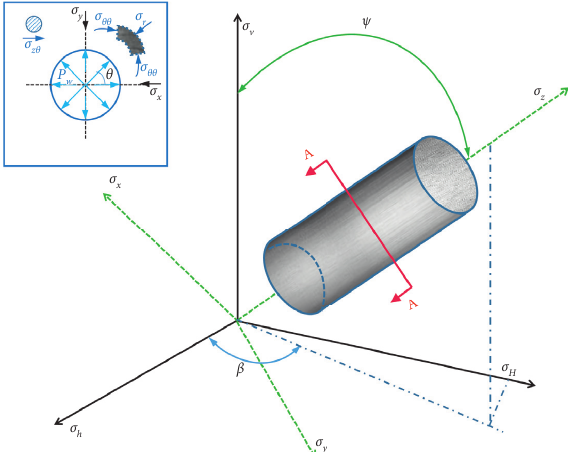
Figure 7: Mechanical model of fracture initiation